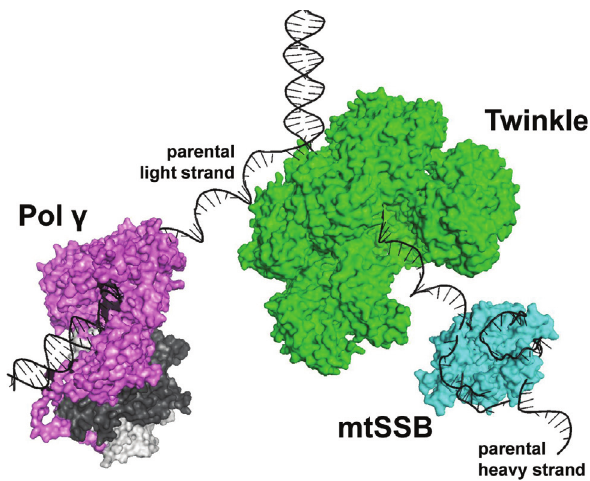
Figure 1 - The mitochondrial replisome at a replication fork during mtDNA heavy-strand synthesis. The nuclear-encoded proteins that form the replisome are represented by the crystal structure of Pol (cid:2) (PDB: 4ZTZ), and the models of mtSSB (Oliveira et al. , 2011) and Twinkle (Kaguni and Oliveira, 2016). The dimeric accessory subunit of Pol (cid:2) is de- picted in two tons of gray. The software Pymol (www.pymol.org) was used to analyze the structures and models and to create the figure. The scheme is not meant to detail structural and/or functional aspects of the replisome components; please see Ciesielski et al. (2016) for such infor-